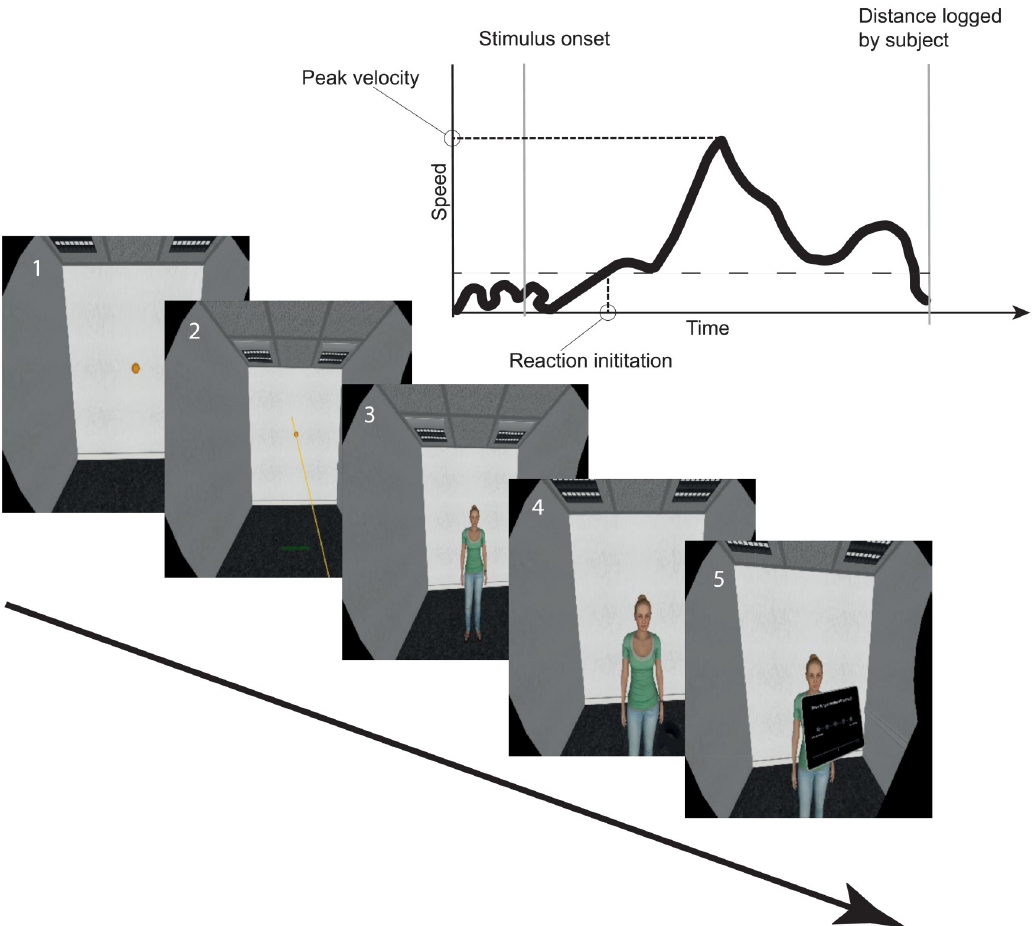
Fig 1. Sample trial from the AAT Experiment. Bottom: Screenshots of one example trial: (1) presentation of the sphere, (2) the subject aiming at the sphere, (3) stimulus onset, (4) the subject approaching the avatar, and (5) rating of the avatar. Top: schematic representation of a velocity curve within one